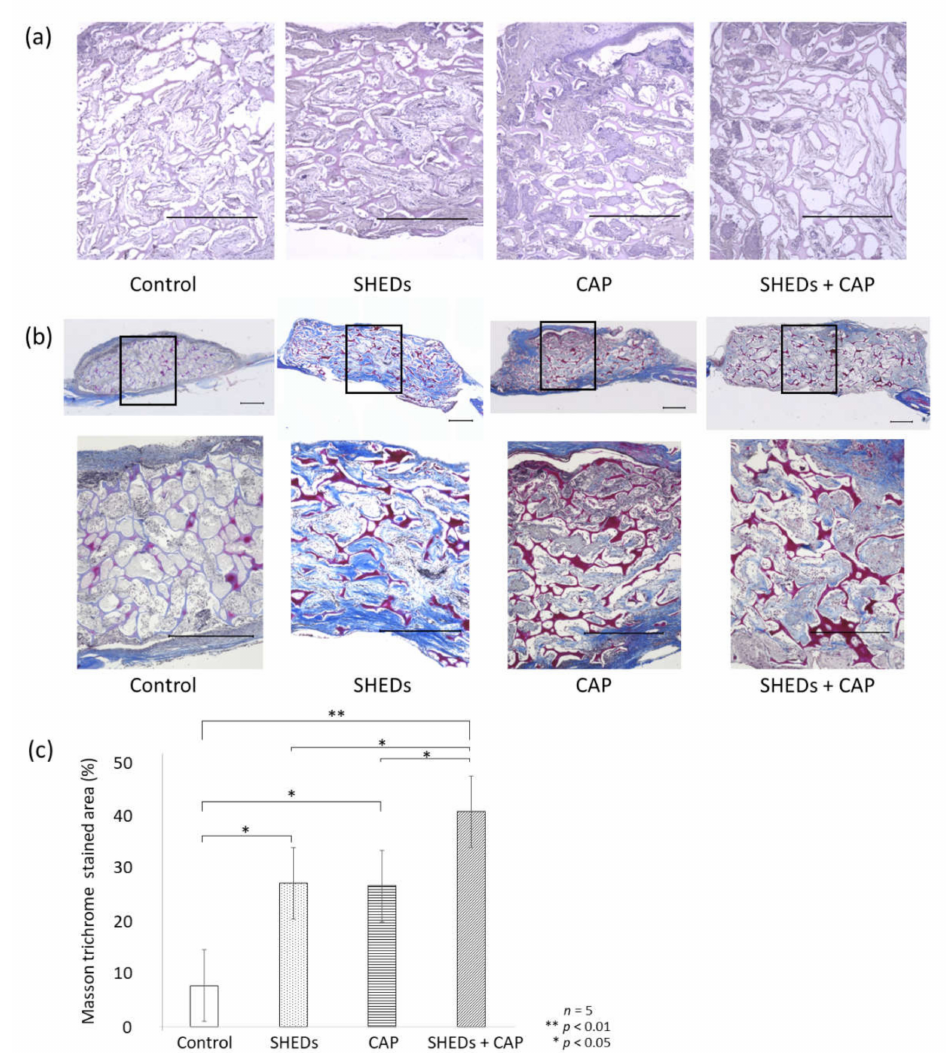
Figure 2. Histological evaluation of regenerated bone area. ( a ) Post H&E staining, the control group showed only a few calcified-like tissues, whereas the SHEDs + CAP group exhibited many such tissues. ( b ) MT staining showed a clear staining site for mature bone in the SHEDs, CAP, and SHEDs + CAP groups but not in the control group. ( c ) Percentage of stained area was significantly higher in the SHEDs + CAP group than in the other groups. n = 5 for each group, ** p < 0.01, * p < 0.05. Scale bars = 500 µ